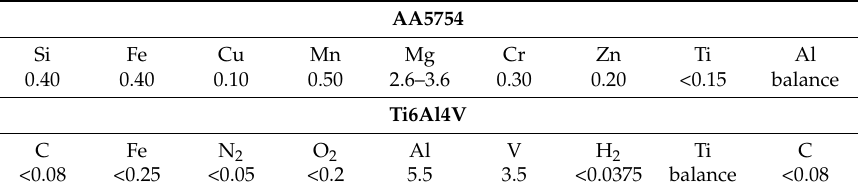
Table 1. Chemical composition of AA5754 aluminum and Ti6Al4V titanium alloys (wt %).